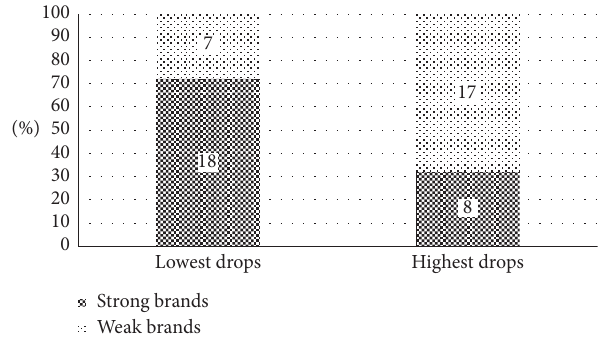
Figure 2: The difference of CARs affected by firms’ brand